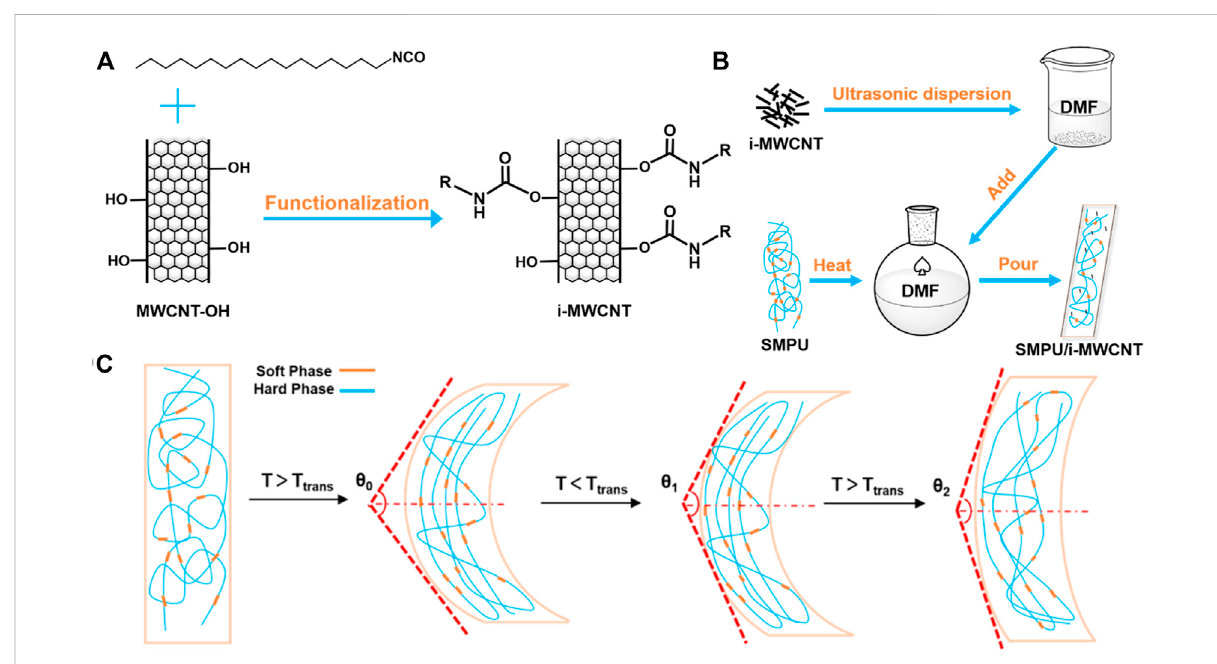
FIGURE 1 (A) Synthesis of i-MWCNT. (B) Preparation of SMPU/i-MWCNT composites. (C) Schematic illustration of the shape memory behavior